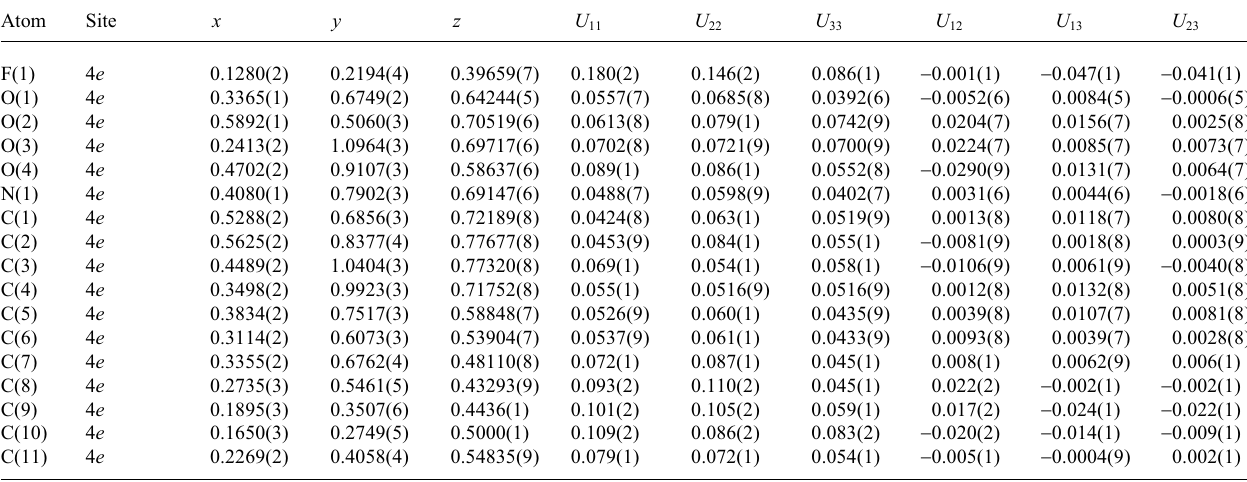
Table 3. Atomic coordinates and displacement parameters (in Å 2 )